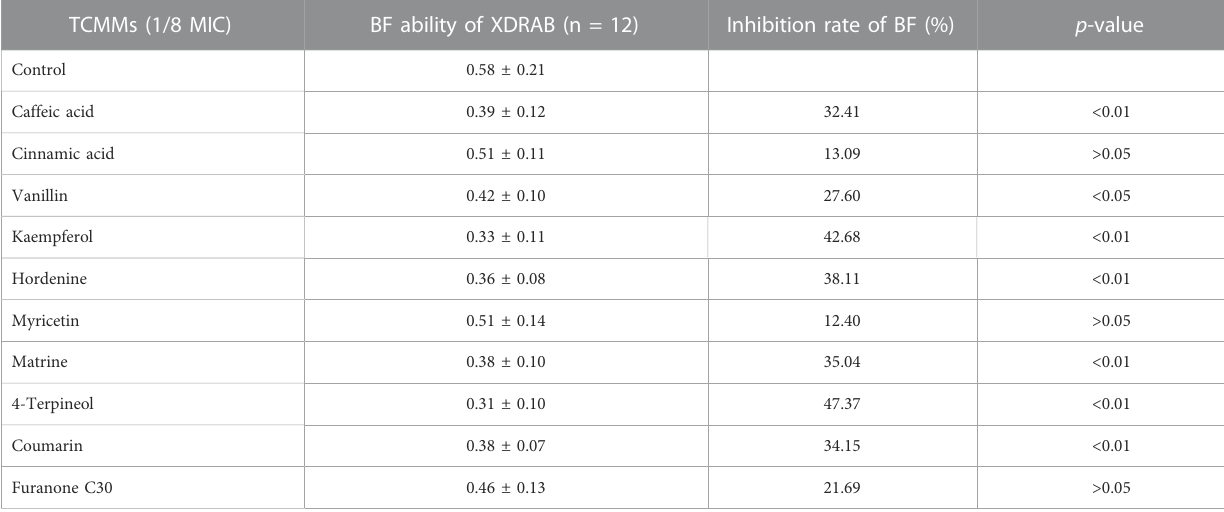
TABLE 5 Effect of 9 TCMMs on the bio fi lm formation ability of XDRAB at 1/8 MIC (x ± s, n = 12). TCMMs (1/8